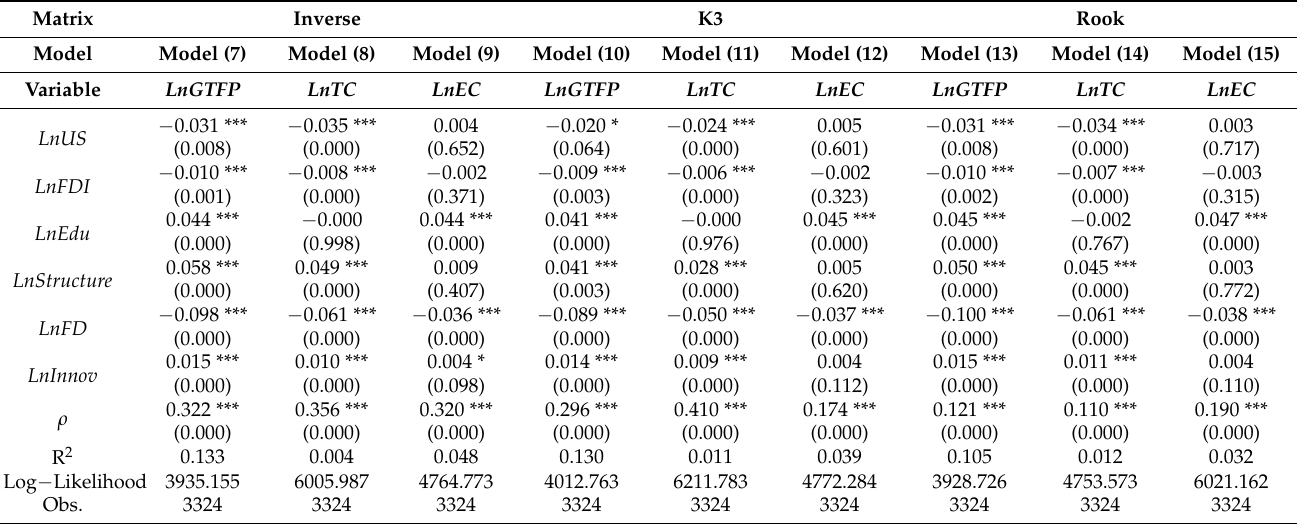
Table 4. Results of two-way fixed effects spatial lag panel data models (Key variable: US = sprawl level). Matrix Inverse K3